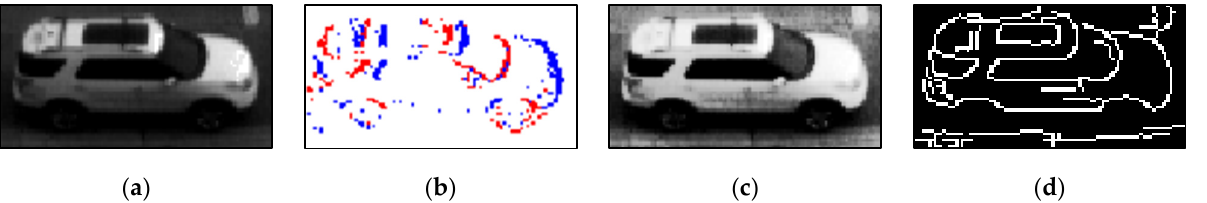
Figure 5. Visualization of ( a ) the actual grayscale image crop based on the bounding box of the detected object; ( b ) event-based mask created from the accumulated events in the current window frame used in event-based tracking; ( c ) a histogram-equalized version of the crop; and ( d ) the generated edge-based mask used for event-based tracking as well.